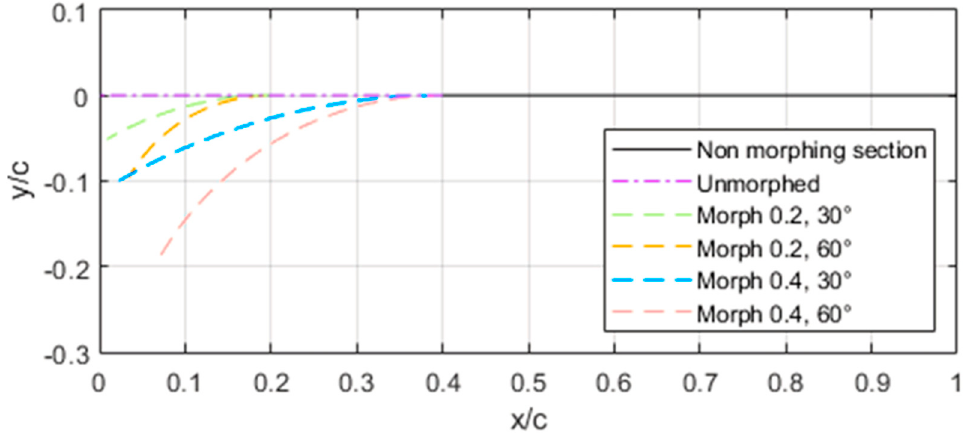
Figure 6. Deflection arcs for different morphing conditions.